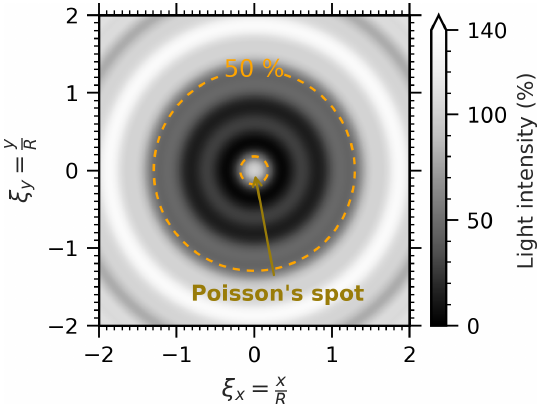
Figure 1. Theoretical diffraction pattern simulated for an opaque disc with diameter D = 2 R at dimensionless distance Z d = Zλ/R 2 = 1 . 0. The orange dashed line represents the 50% inten- sity threshold. Due to diffraction, a bright spot – called Poisson’s spot – appears at the center of the shadow diffraction pattern.